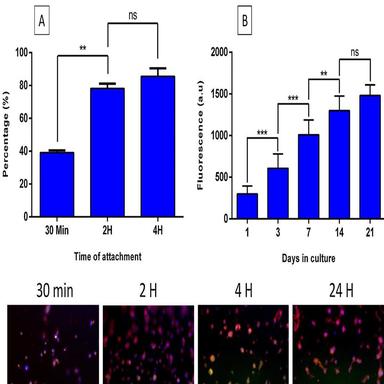
A) Percentage of HFF-1 seeding efficiency on a ZS-EI-ELR hydrogel surface. B)Alamar blue reduction of cells seeded upon a ZS-EI-ELR printed scaffold. C)Immunostaining of actin (red), vinculin (green), and nuclei (blue) of HFF-1 cells at early adhesion for different time points (30 min, 2 h, 4 h and 24 h) over ZS-EI-ELR hydrogels. Scale bar 100 m (ns P > 0.05; \P < 0.05; \\P < 0.01; \\\P < 0.001; \\\\P < 0.0001).